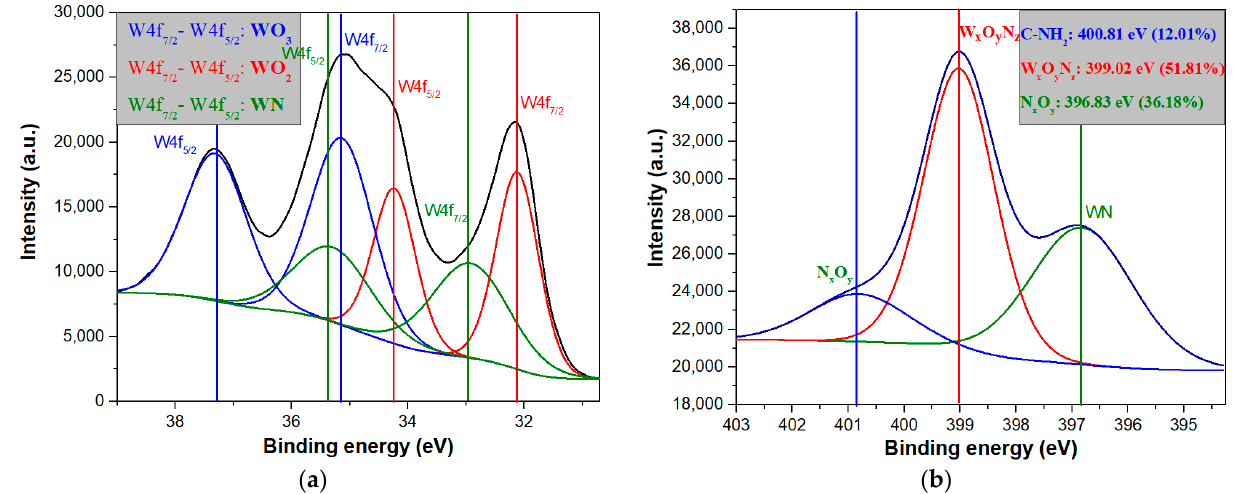
Figure 16. XPS deconvolution results for hybrid nanostructures obtained in plasma on condition in ( a ) W4f region ( b ) N1s region.